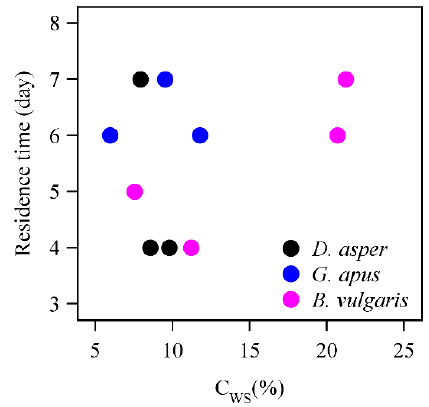
Figure A2. Deuterium signature ( δ D, ‰) in transpired water of labeled culms of B. vulgaris , G. apus, and D. asper over the course of the experiment. Each single line stands for one culm. There are 4, 3, 3 culms included for B. vulgaris , G. apus, and D. asper , respectively.